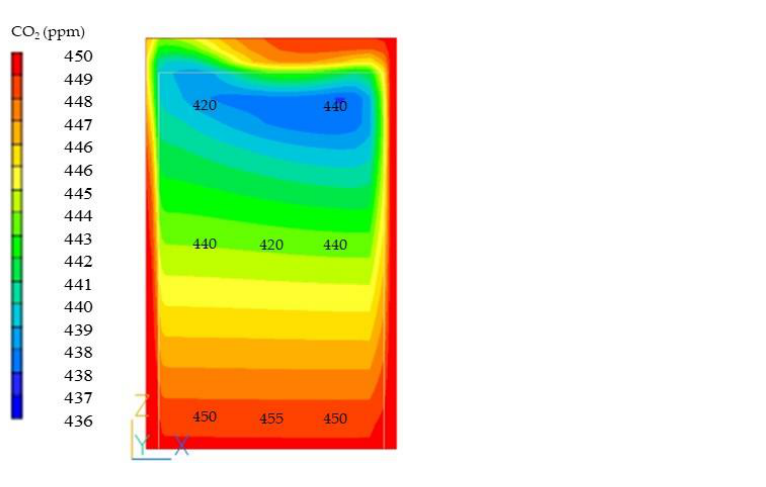
Figure 9. Measured and simulated data of CO 2 concentration inside the chamber. 3.1.2. CO 2 Distribution Inside the Greenhouse The greenhouse model validation was conducted according to the measurement data of Kumazaki, et al. [26], who studied influential positions of CO 2 supply in tomato plants inside the same greenhouse as the present study. In the present study, the simulation re- sults were compared with the measurement data of CO 2 concentration in the condition 20 min after 1 h of CO 2 being supplied at the middle canopy (1.2 m above the ground, see Figure 10). The CO 2 concentrations were measured at two sides of 3.4 m from the north and south wall with 0.6, 1.2, 1.8, 2.4, and 4.2 m above the ground. The initial simulation value of CO 2 concentration was assumed to be constant in every mesh inside the greenhouse, whereas the actual condition has various CO 2 concentrations. In contrast, model simula- tion accuracy was also evaluated by comparing the percentage errors of each measured and simulated point (Table 4).